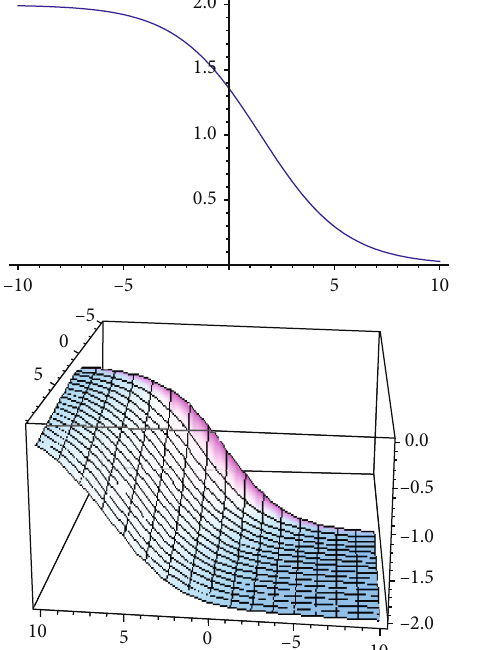
Figure 5: 2D and 3D graphics for hyperbolic traveling wave solution (32) at f β = 0 : 5, r = 1, q = 1, c = 1 g :